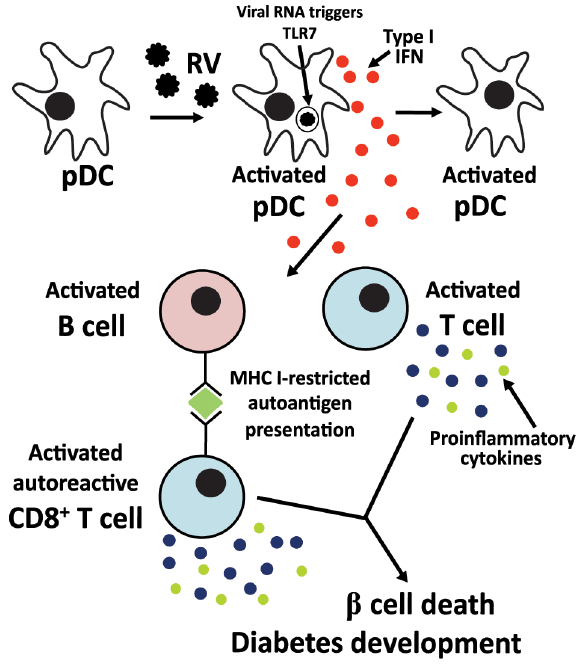
Figure 9. Proposed mechanism for the contribution of rotavirus-induced bystander lymphocyte activation to exacer- bation of diabetes-related autoimmunity. Infectious rotavirus spreads to the PLN and MLN [14], where it infects or is phagocytosed by a minor pDC population. Within endosomes, viral dsRNA is degraded and triggers TLR7 signaling. The resulting secreted type I IFN induces the activation of bystander uninfected pDC, leading to further type I IFN release. Secreted type I IFN also induces the activation of B and T cells, including autoreactive T cells. MHC I expression on B cells is upregulated, increasing the capacity of these cells to present antigen to T cells, including autoantigen to autoreactive T cells [14]. Activated T cells increase proinflammatory cytokine expression [14]. Autoreactive T cells migrate into islets, where proinflammatory cytokine expression contributes to b cell death